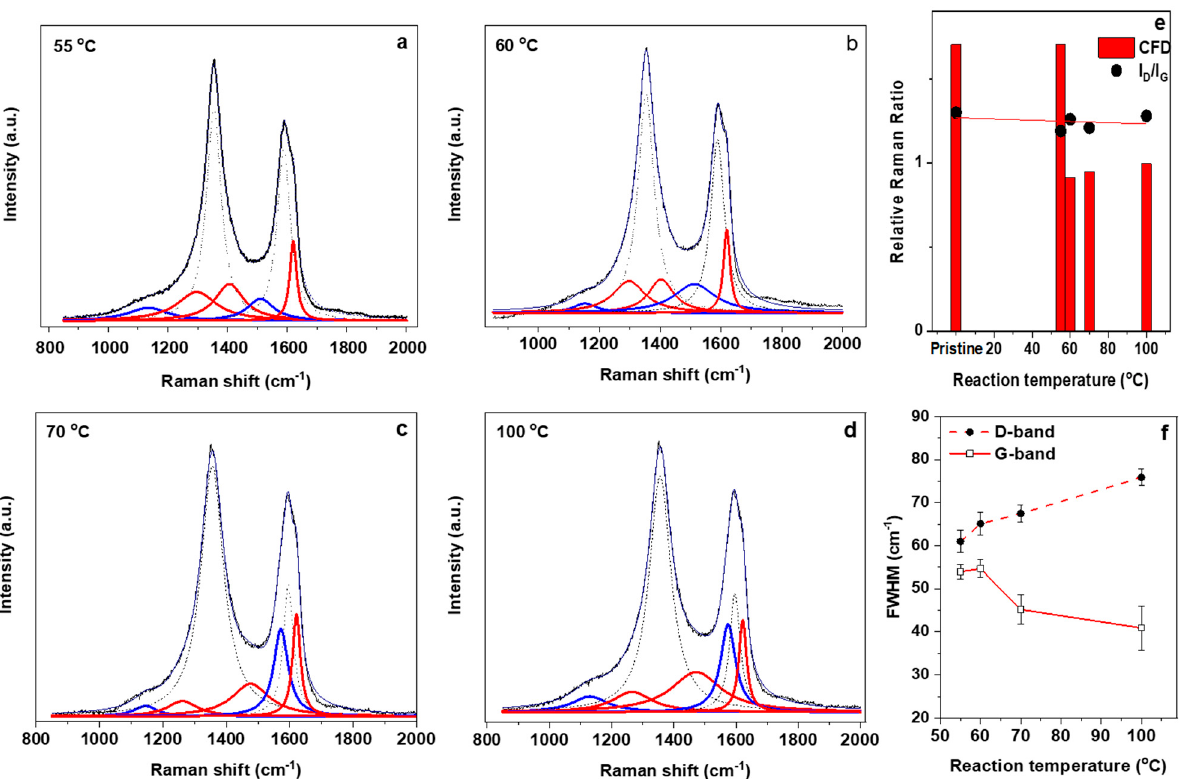
Figure 3. Raman spectroscopy is further used to evaluate the effect of temperature on the mild oxidative reflux functionaliza- tion technique. As shown in figure ( a – d ), the deconvolution method shows that a distinct spectral shift occurs, particularly to the shoulder bands nearest to the D and G overlap. As the temperature increases the D R and G L peaks show the largest increase. This shifting of dominance with respect to relative area can be used as a metric to track the increase in out of plane vibrational modes related to the functional group attachments. ( e ) As before, the change in effective area of the satellite peaks is more sensitive to the structural changes than the I D /I G ratio. ( f ) The main reason for the change in the chemical functionalization degree (CFD) is due to a change in weighting of the D R and G L modes.